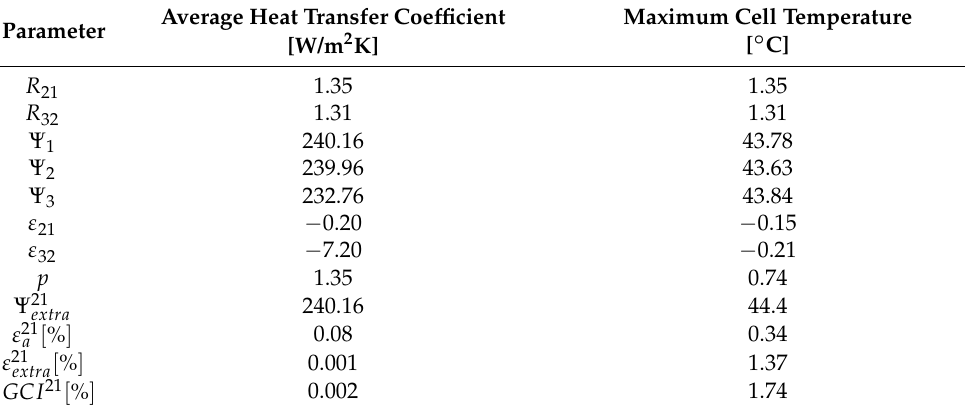
Table 8. Discretization errors from the grid independence study performed on the base immersed cooling